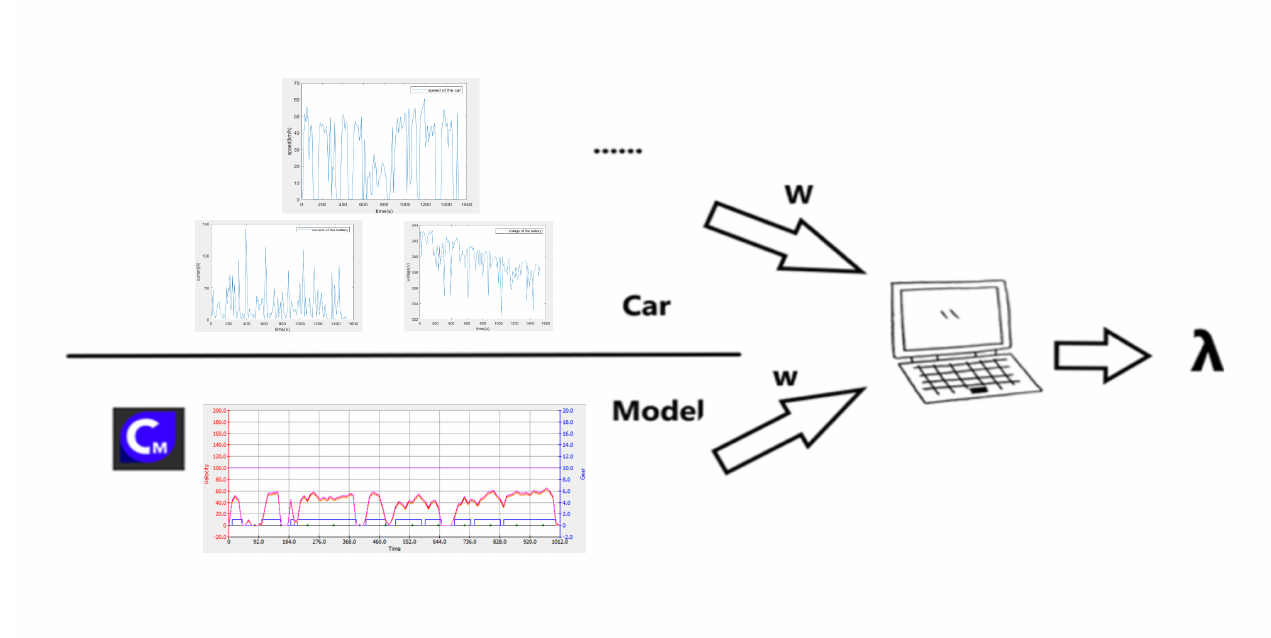
Figure 8. The process to obtain the compensation coefficient λ